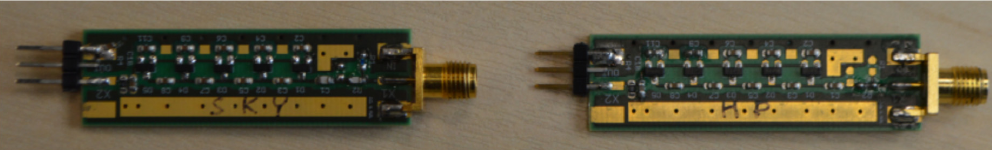
Figure 1. Schematic diagram of the self ‐ developed RF ‐ EH (five ‐ stage voltage multiplier).